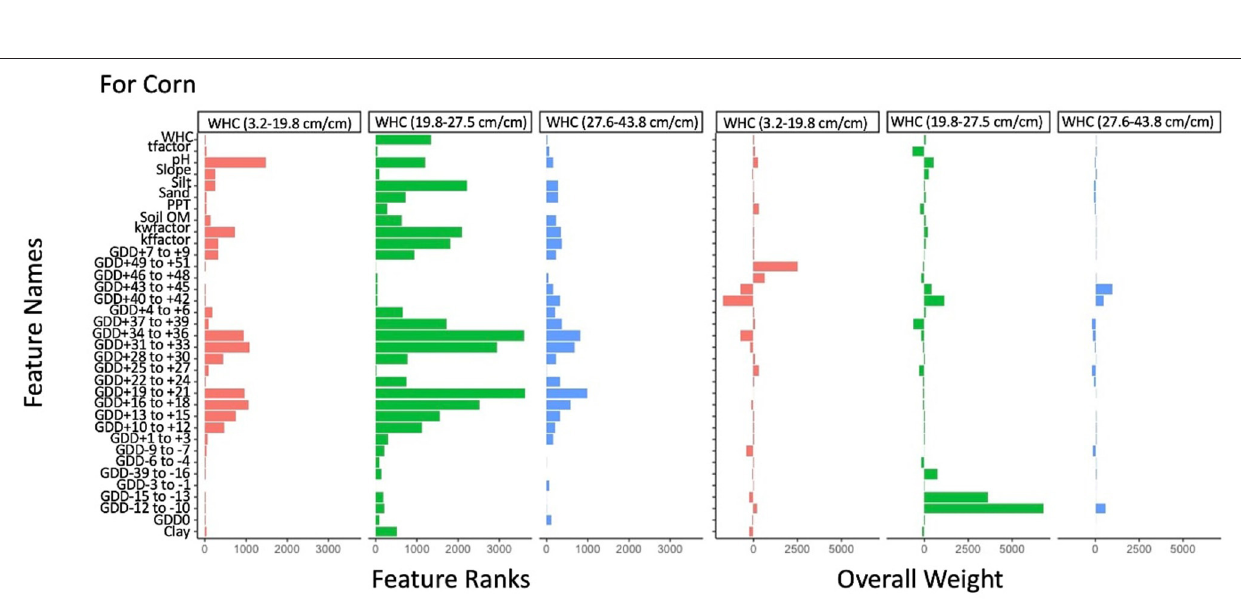
Frontiers in Sustainable Food Systems |